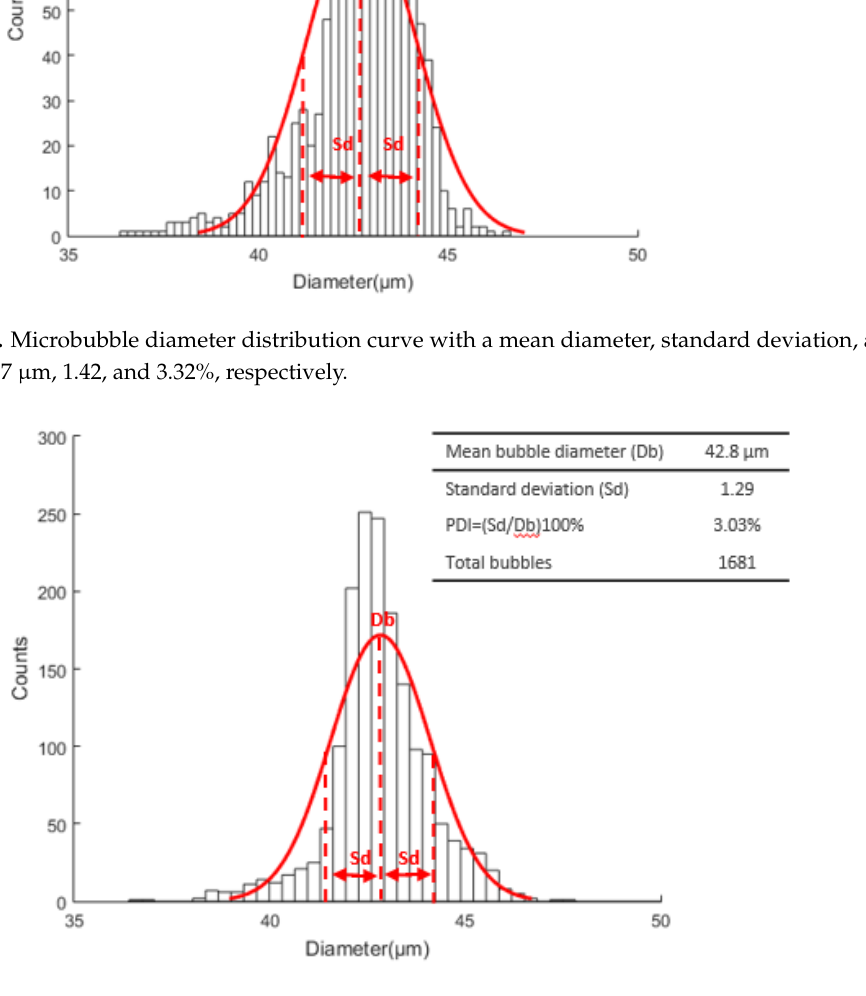
Figure 16. Microbubble diameter distribution curve with a mean diameter, standard deviation, and PDI of 42.8 μm, 1.29, and 3.03%, respective ly.